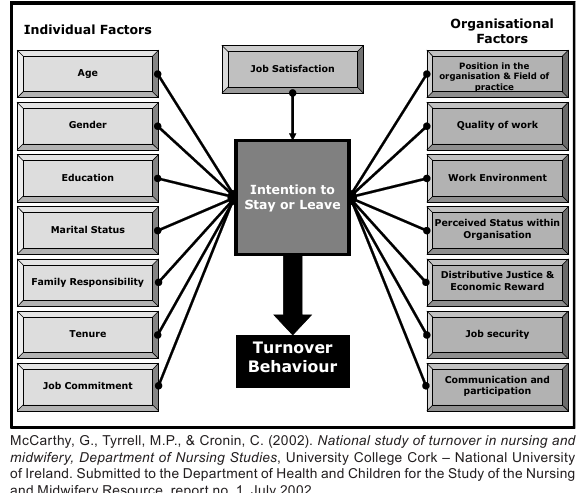
FIGURE 2 Conceptual framework of the turnover determinants of McCarthy